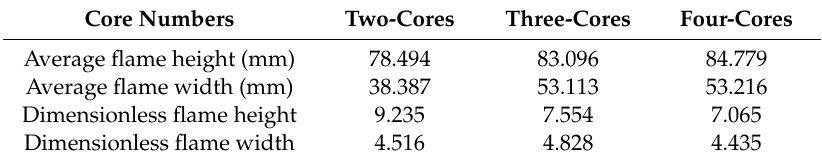
Figure 4. Change of flame size of a single cable with di ff erent core numbers. ( a ) Flame height; ( b ) flame width. Table 4. Average flame size of a single cable with di ff erent core